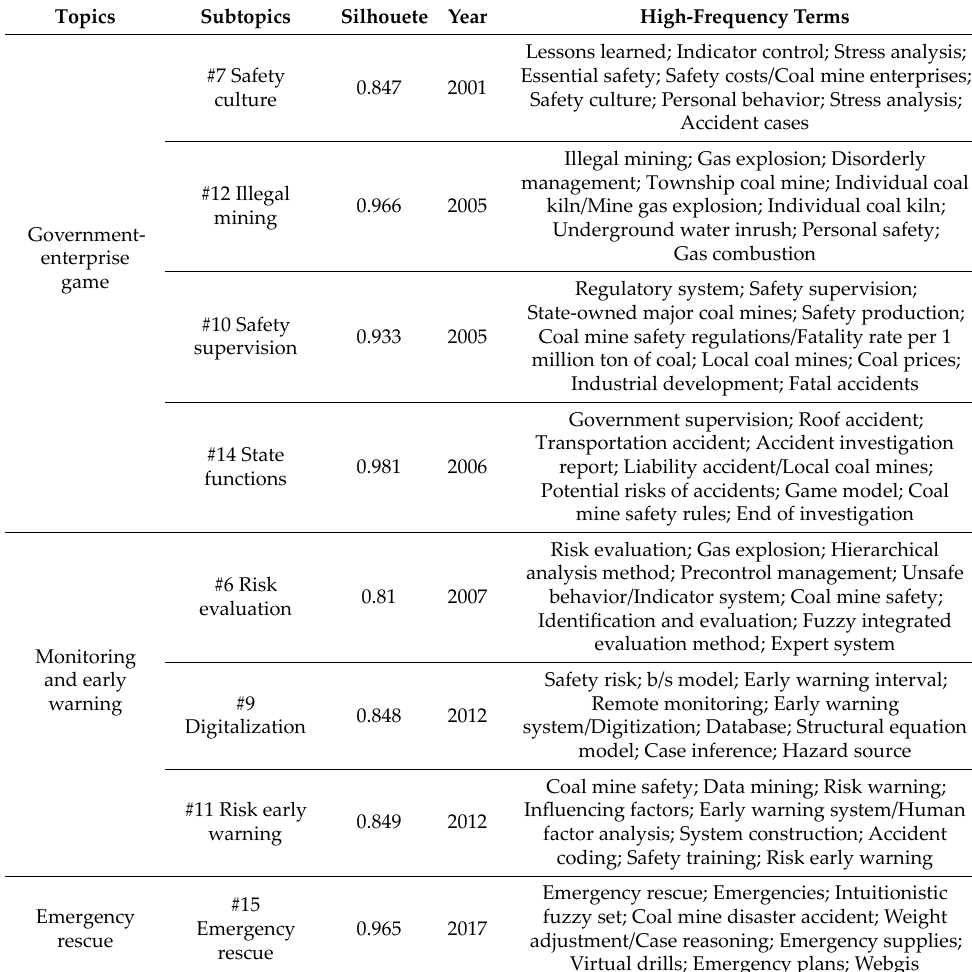
Table 3. Topic and top term of coal mine safety